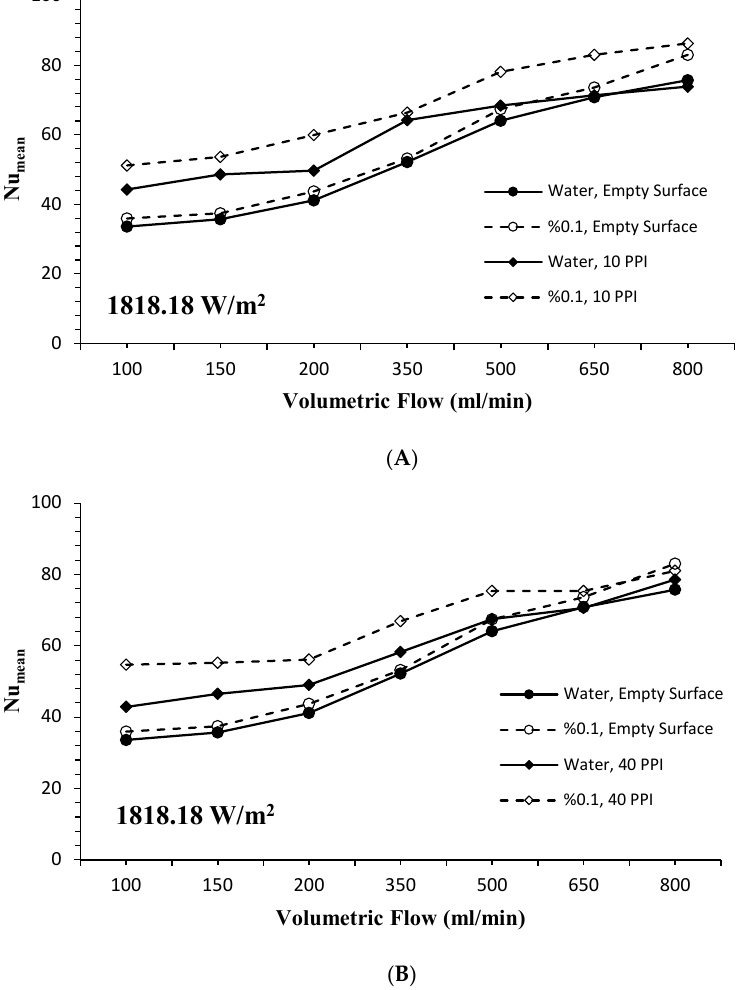
Figure 8. Variation of mean Nusselt number against volumetric flow rate as a result of using PHSs with nanofluid ( A ) 10 PPI; ( B ) 40 PPI.